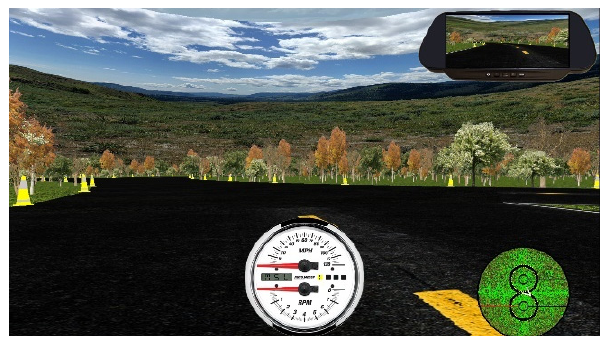
Figure 7. The figure-8 scenario (CC).